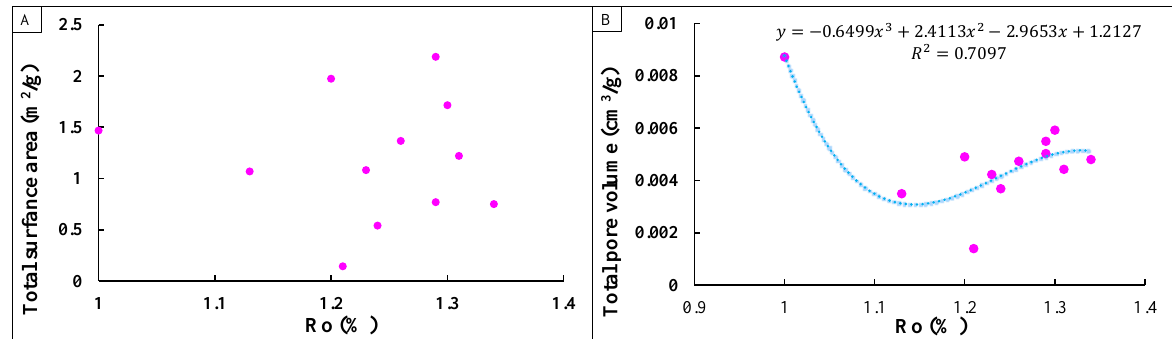
Figure 12. ( A ) Correlations between vitrinite reflectance and total surface area of the shales in the study area. ( B ) Correlations between vitrinite reflectance and total pore volume of the shales in the study